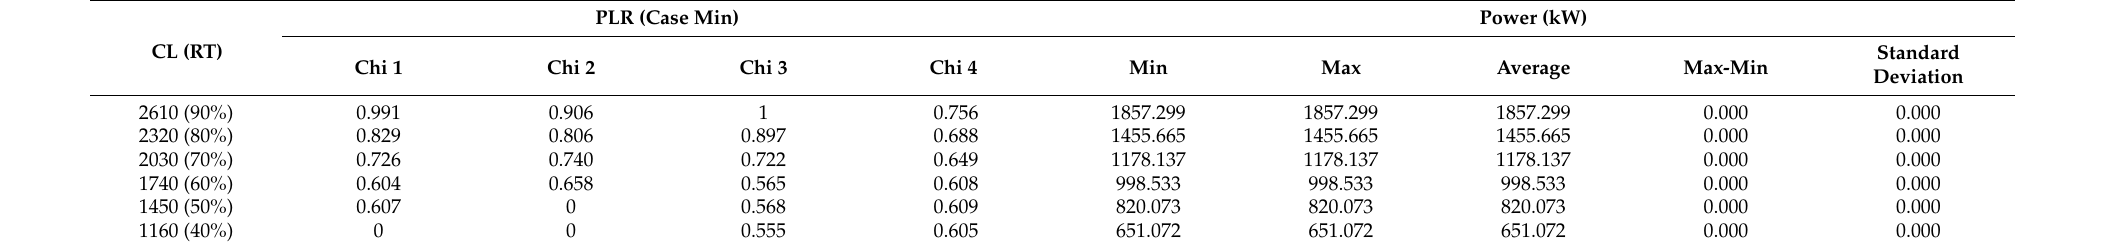
Table 10. Power Consumption of chillers in Case 2 operated by TPSO algorithm.